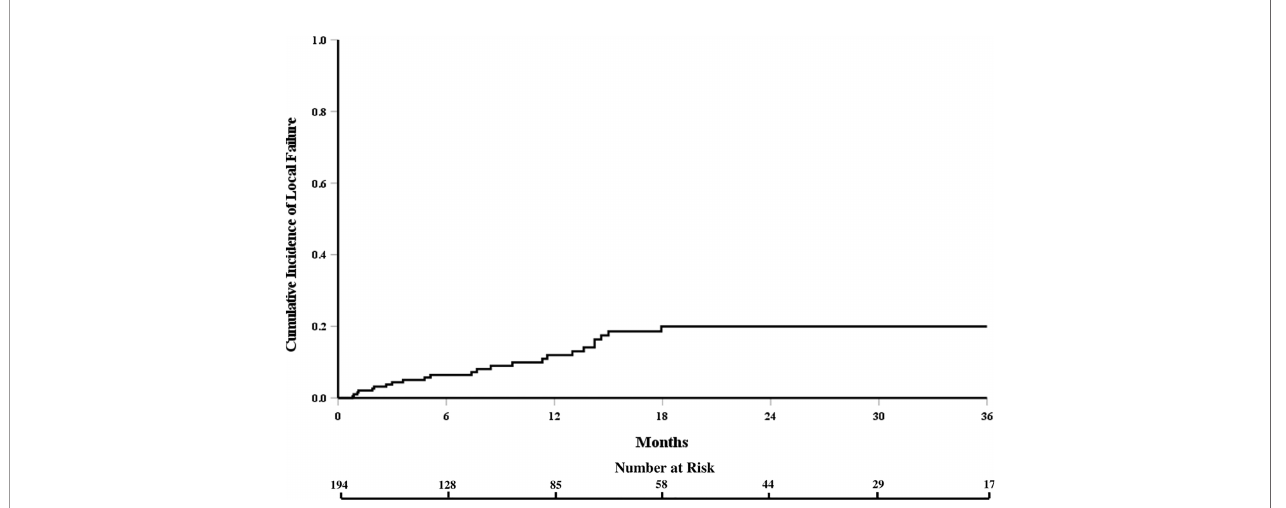
FIGURE 1 | Cumulative incidence of local failure for the entire cohort of patients receiving spine stereotactic body radiation